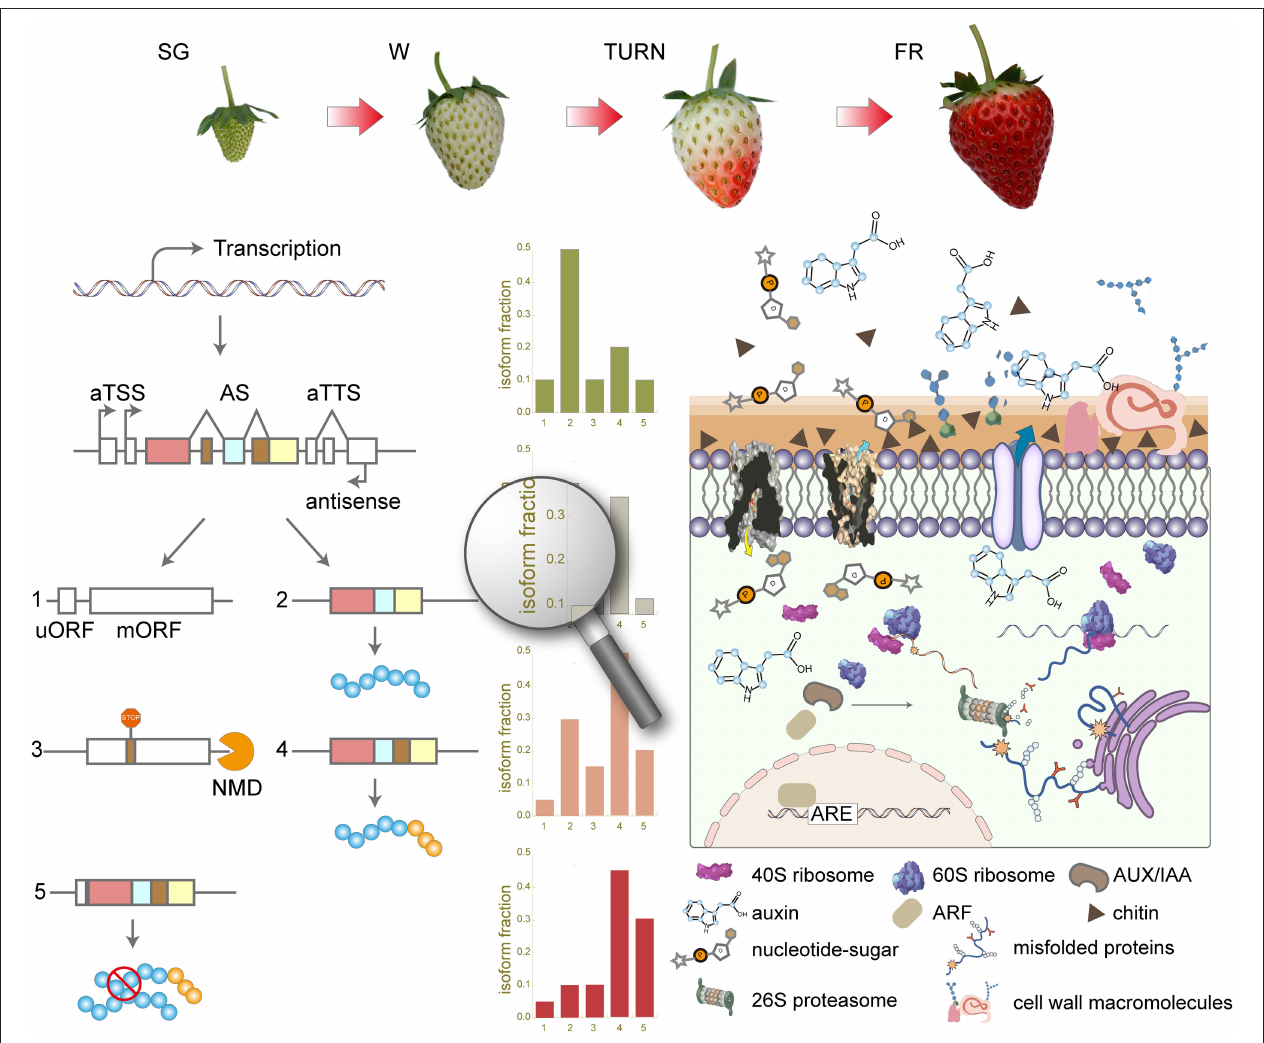
FIGURE 7 | Summary of the transcriptome complexity introduced by alternative transcription start site (aTSS), alternative transcription stop site (aTTS), and alternative splicing (AS) in the strawberry fruit development and maturation. SG, small green; W, white; TURN, turning stage; FR, full red stage; uORF, upstream open read frame; mORF, main open reading frame; NMD, non-sense-mediated mRNA decay; ARF, auxin response factor; ARE, auxin response elements; ERAD, endoplasmic-reticulum-associated protein degradation.